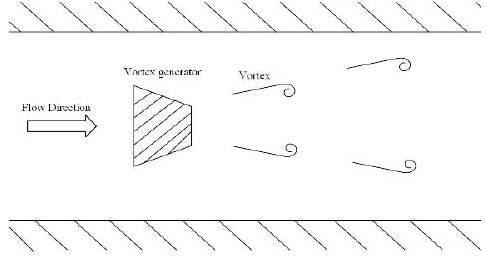
Fig. 1. Schematic diagram of Kaman Vortex Street.